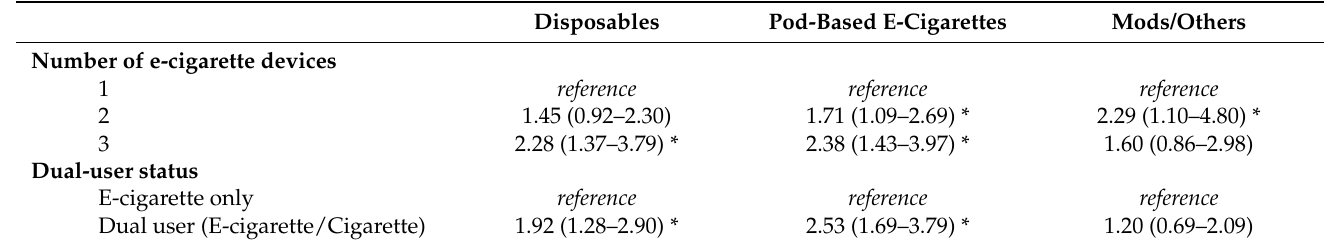
Table 3. Odds ratio of HONC dependence (HONC ≥ 1) by increasing number of e-cigarette devices used in the past 30 days and dual